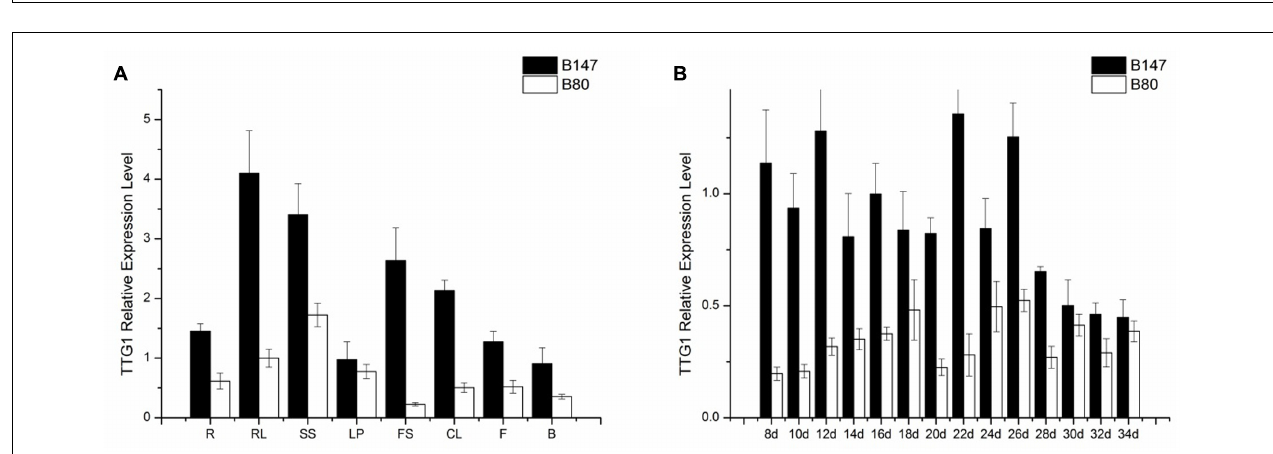
FIGURE 3 | Genetic and physical maps of the Brsc-ye gene and the candidate gene identification. (A) Fine mapping of the Brsc-ye gene. The Brsc-ye gene was mapped to the region between markers SSR449a and SSR317 (Ren et al., 2017). (B) Candidate region of the Brsc-ye locus. The Brsc-ye locus was delimited to a 40.2 kb region in the B. rapa scaffold and there were three predicted genes in this region based on the genome sequence of B. rapa.